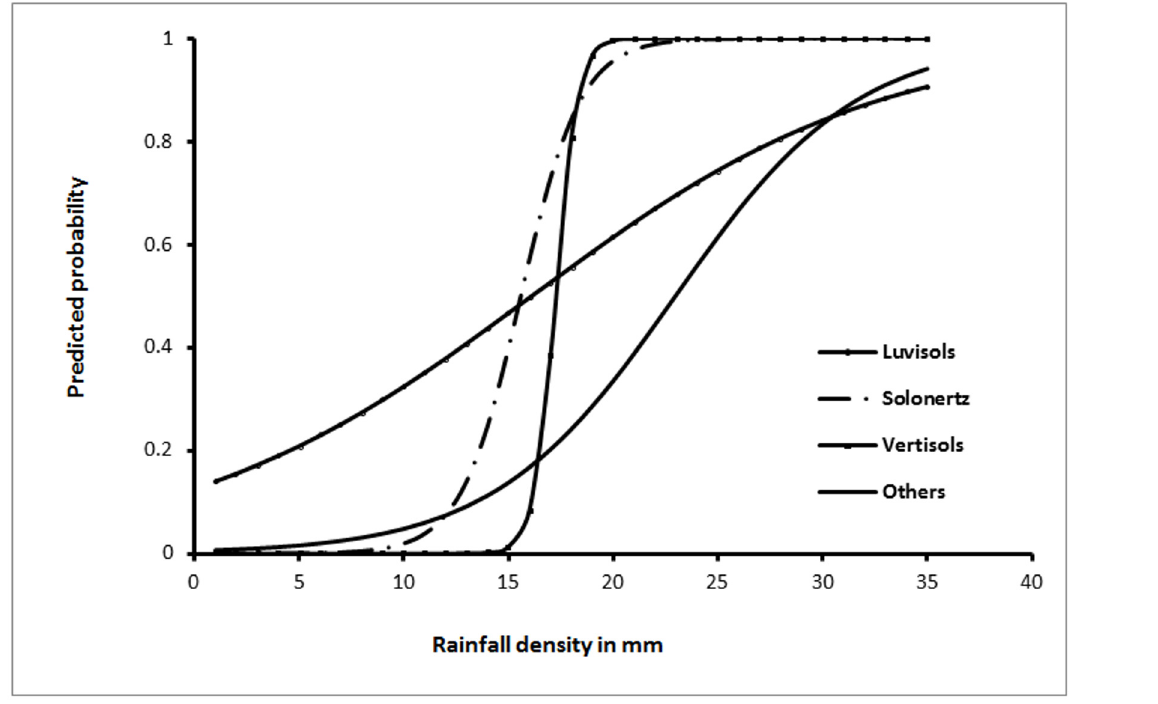
Fig 2. Graphical interpretation of the effects of rainfall and soil type on the risk of RVF